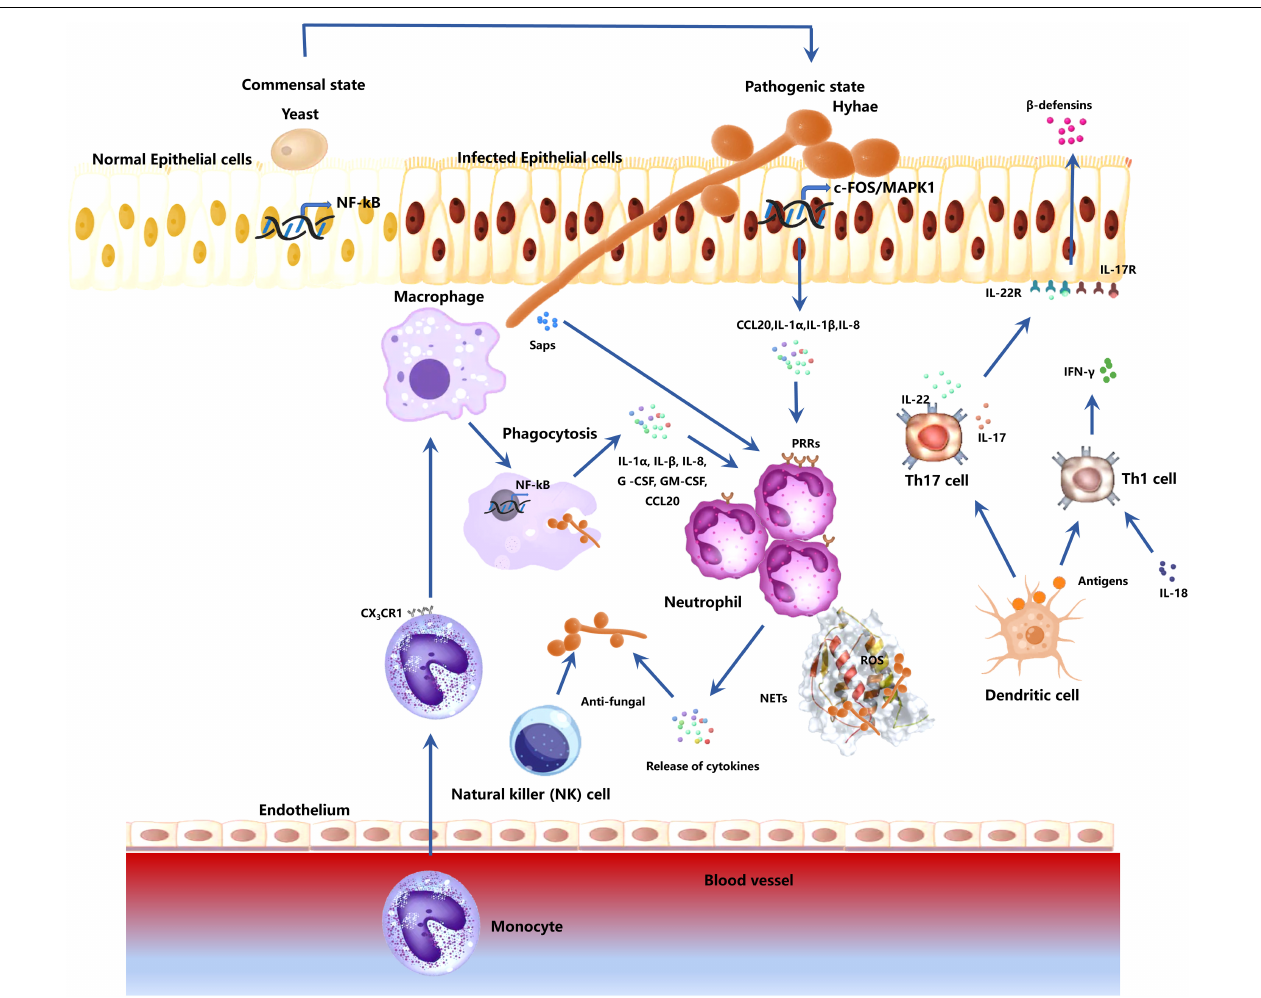
FIGURE 2 | Responses of host immune-related cells during C. albicans mucosa invasion. The fungus transforms from a commensal to a pathogenic state by first breaking through the epithelial cells. Epithelial cells activate mitogen-activated protein kinase 1 (MAPK1)- and FOS-related pathways to mediate cytokine production (CCL20, IL-1 α , IL-1 β , IL-8). These cytokines can recruit host immune cells. Epithelial cells also release β -defensins for anti-candida activities. The macrophages in the tissue contribute to the antifungal effect through phagocytosis and secretion of cytokines (IL-1 α , IL- β , IL-8, G-CSF, GM-CSF, CCL20). Monocytes in the blood are recruited. They migrate to the infected sites, differentiate into macrophages, and participates in anti- C. albicans process. Neutrophils respond to cytokines secreted by macrophages and epithelial cells, and fungal antigenic substances Saps. Neutrophil activation induces the production of active antifungal substances to kill the fungi. Neutrophil can also release neutrophil extracellular traps (NETs) and reactive oxygen species (ROS) to kill the C. albicans, which cannot be engulfed due to the large hyphae. DC cells activate Th cells via antigen presentation. Th17 activation induces IL-17 and IL-22 production, which are involved in the recruitment